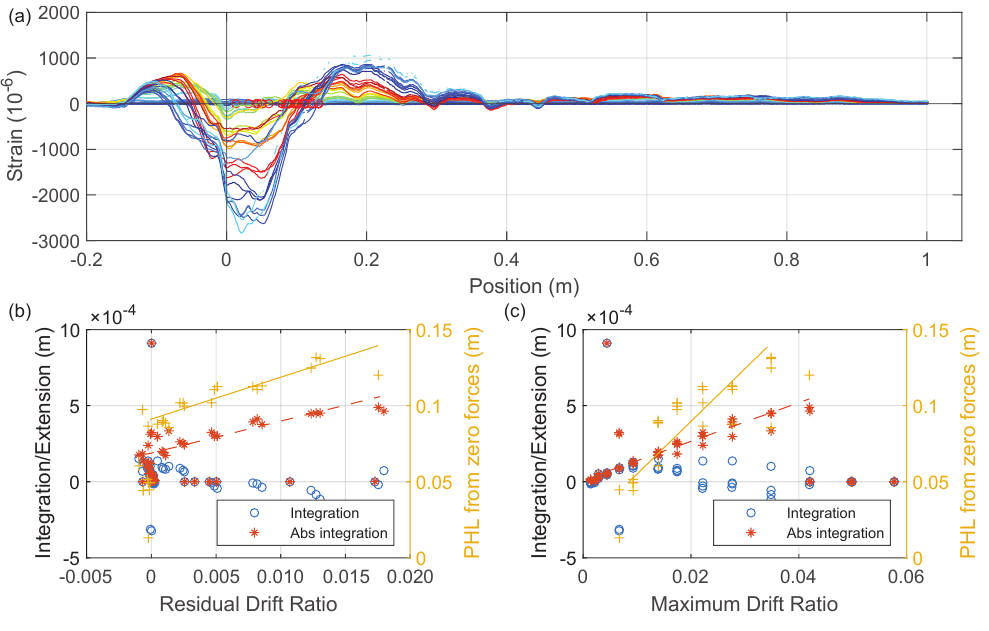
Figure 28. ( a ) Strain measurements at zero forces with positive drifts for A2-Beam left (down to up Silicon-PFA). ( b ) Proposed damage indices from residual DFOS strain readings vs. residual drift. ( c ) Proposed damage indices from residual DFOS strain readings vs. maximum drift.